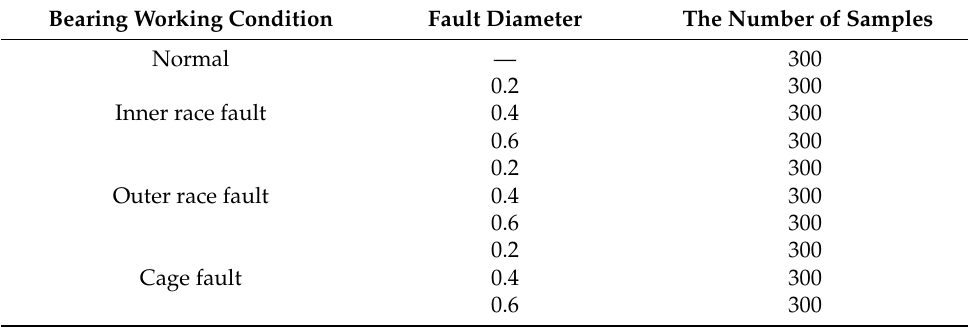
Table 7. Details of rolling bearing operation conditions.